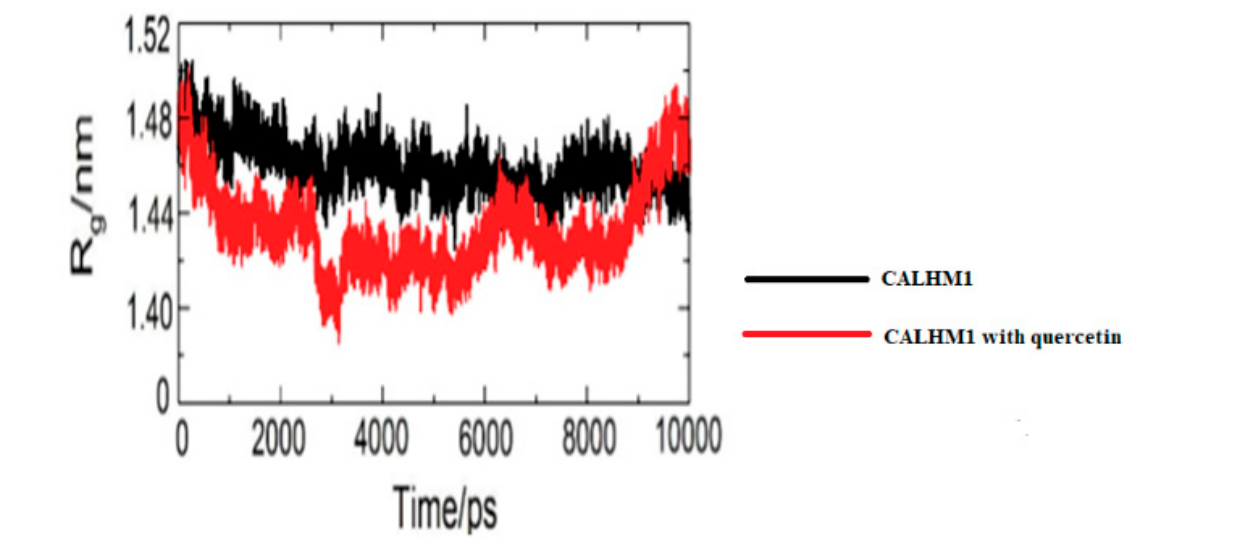
Figure 14. Radius of gyration (Rg) during 10,000 ps of MD simulation of unliganded CALHM1 and CALHM1–quercetin complex.